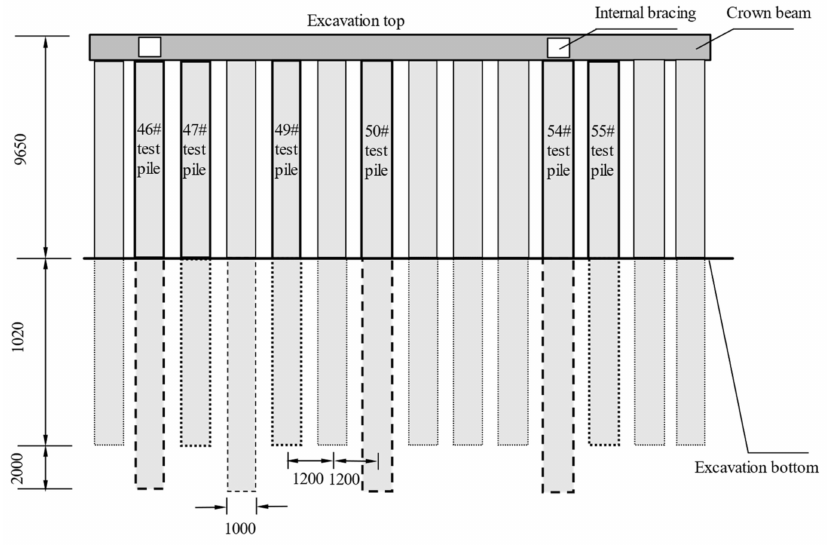
Figure 4. The schematic cross-section of the test pile (unit: